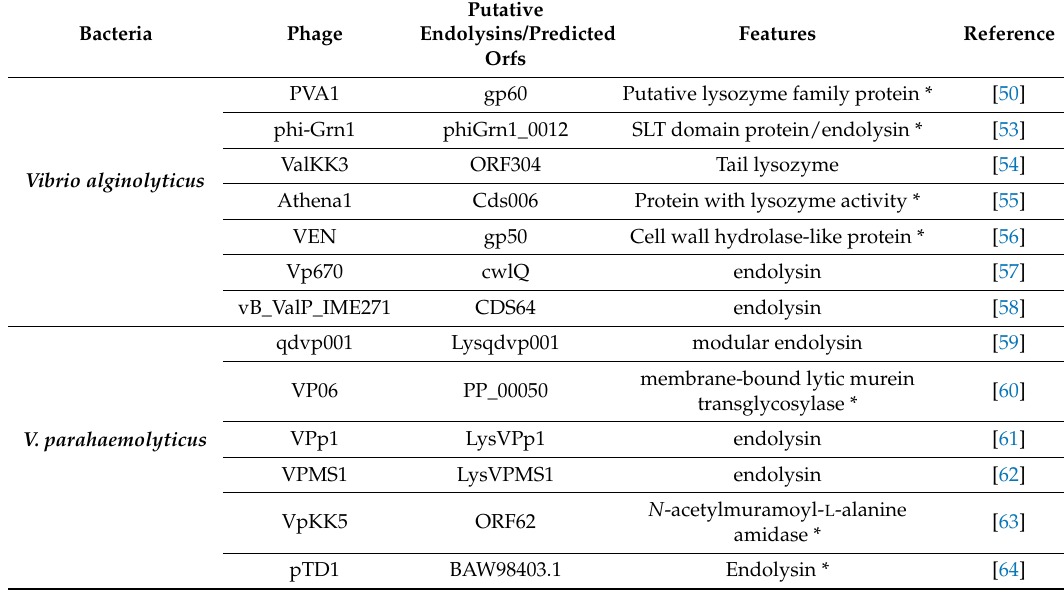
Table 1. Showing endolysins of Vibrio alginolyticus and V. parahaemolyticus phages. Bacteria